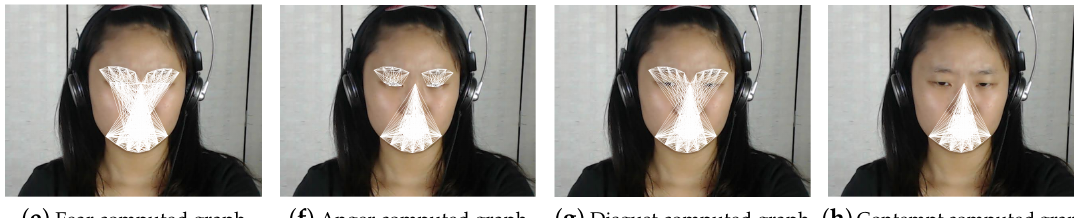
Figure 2. FACS-based graphs of different emotions.